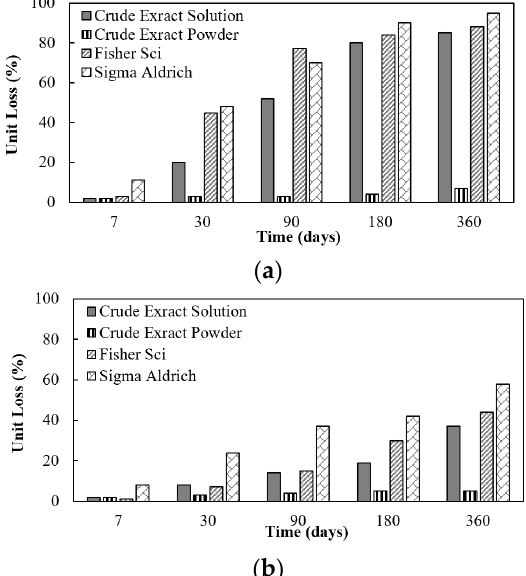
Figure 6. Percentage of unit loss of the jack bean crude extract, Fisher Scientific, and Sigma Aldrich at different storage times at ( a ) RT and ( b ) 4 °C.